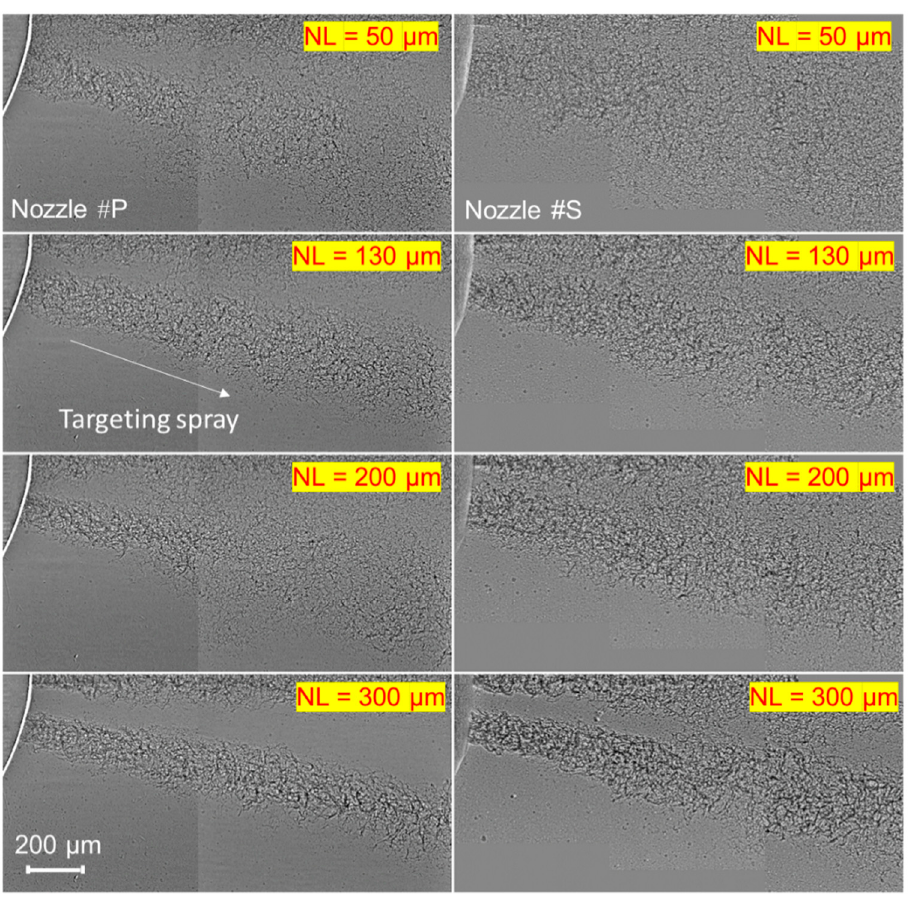
Figure 6. High-speed images of the injected sprays at the same needle lifts. ( NL stands for the needle lift, and the targeting spray is inclined). lift, and the targeting spray is